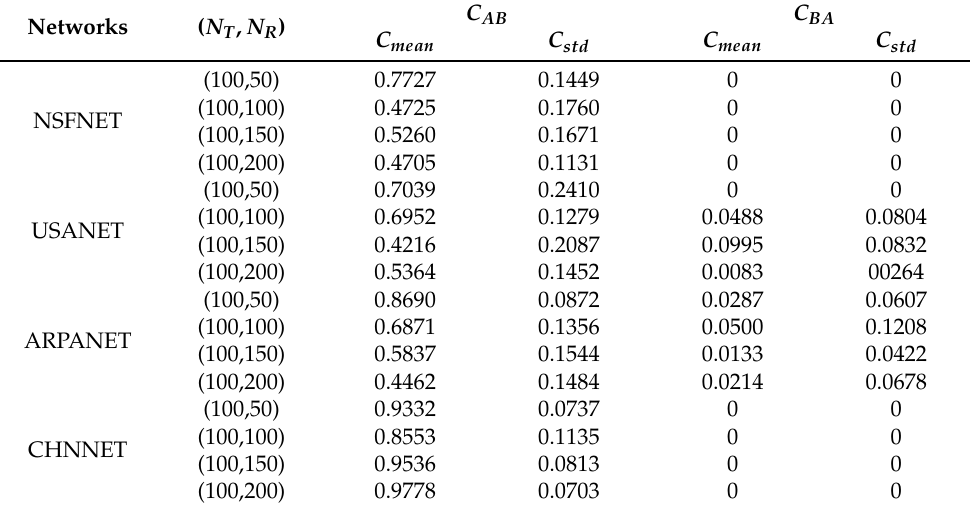
Table 3. Comparison of